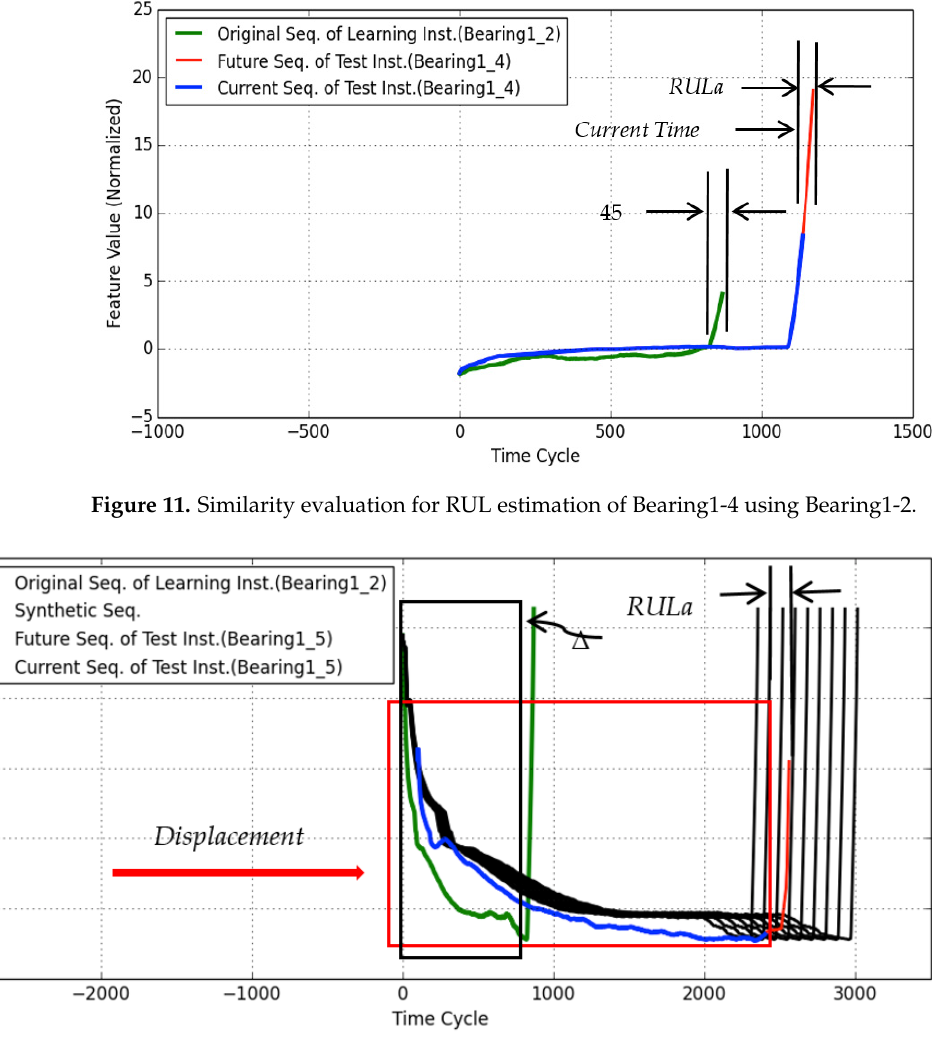
Figure 11. Similarity evaluation for RUL estimation of Bearing1-4 using Bearing1-2.